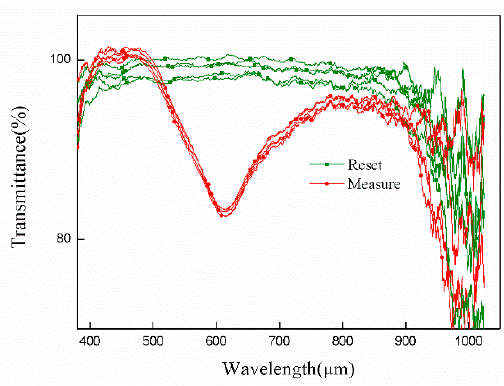
Figure 10. The measurement and recovery curves obtained by repeated testing of the sensors.